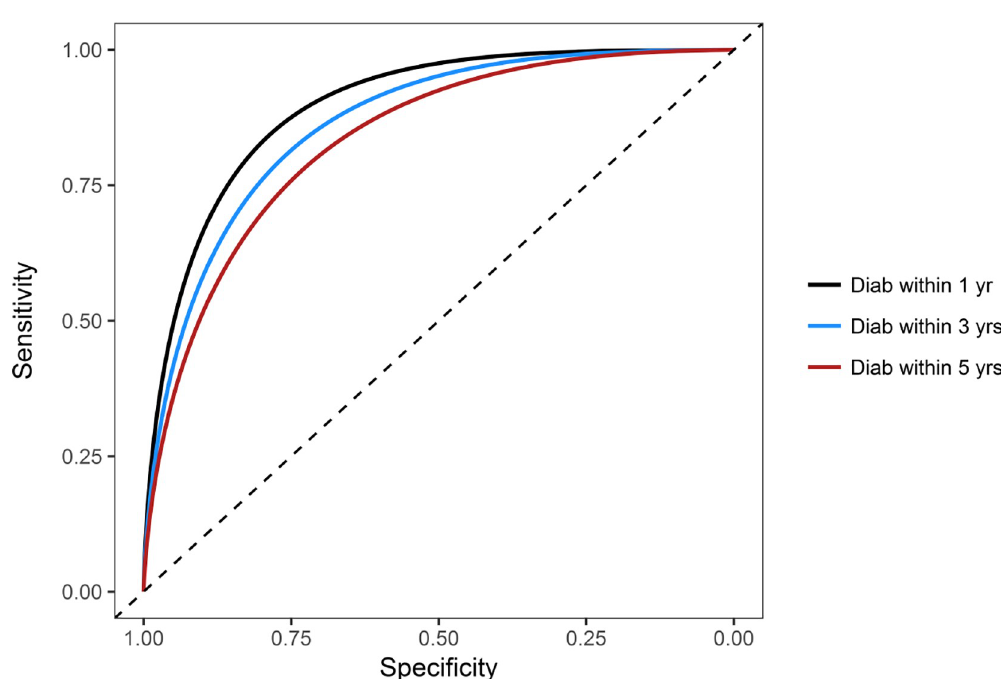
Fig 1. ROC curves for at least 2 RPGs � a cutoff to predict a diagnosis of diabetes within 1, 3, and 5 years. p < 0.0001 for ROC AUC for 1 year vs 3 years, and for 3 years vs 5 years.